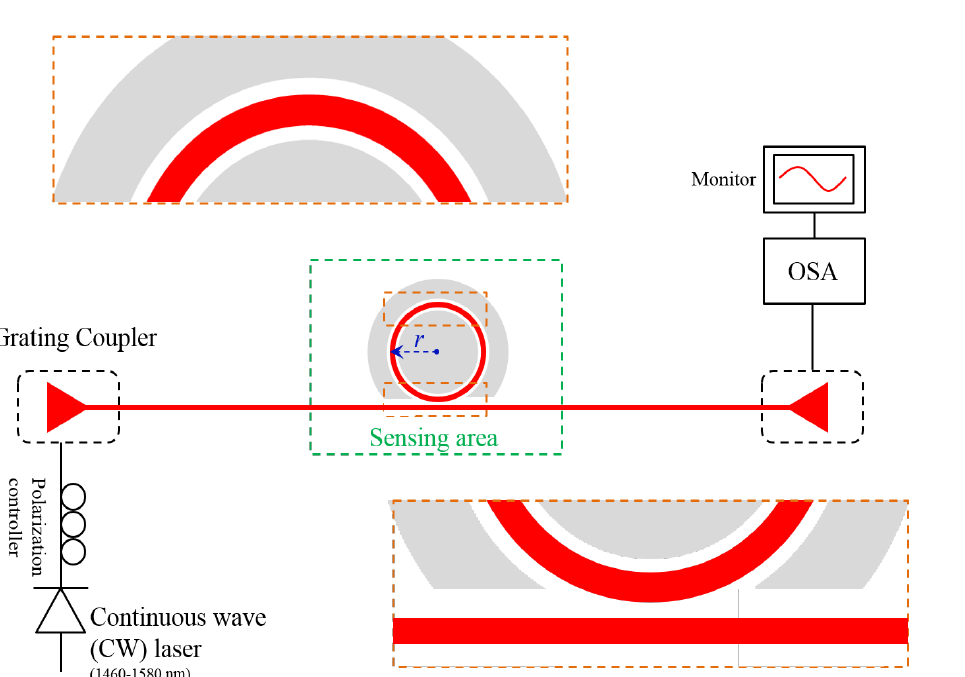
Figure 3. Schematic of the Si bus waveguide side-coupled double-slot hybrid plasmonic ring sensor. The sub-figures are the detailed structures of the coupling area and the DSHP